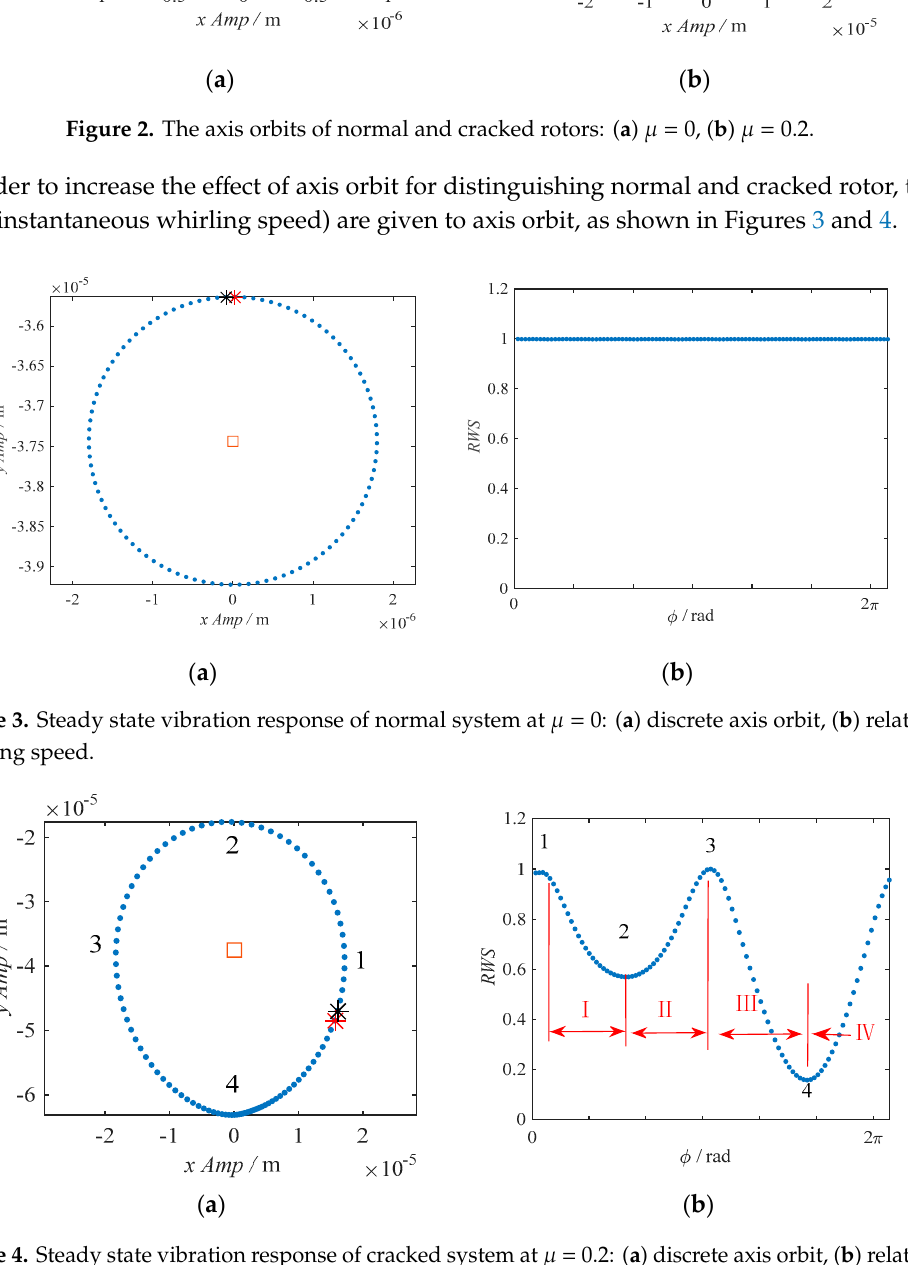
Figure 4. Steady state vibration response of cracked system at μ = 0.2: ( a ) discrete axis orbit, ( b ) relative whirling speed.